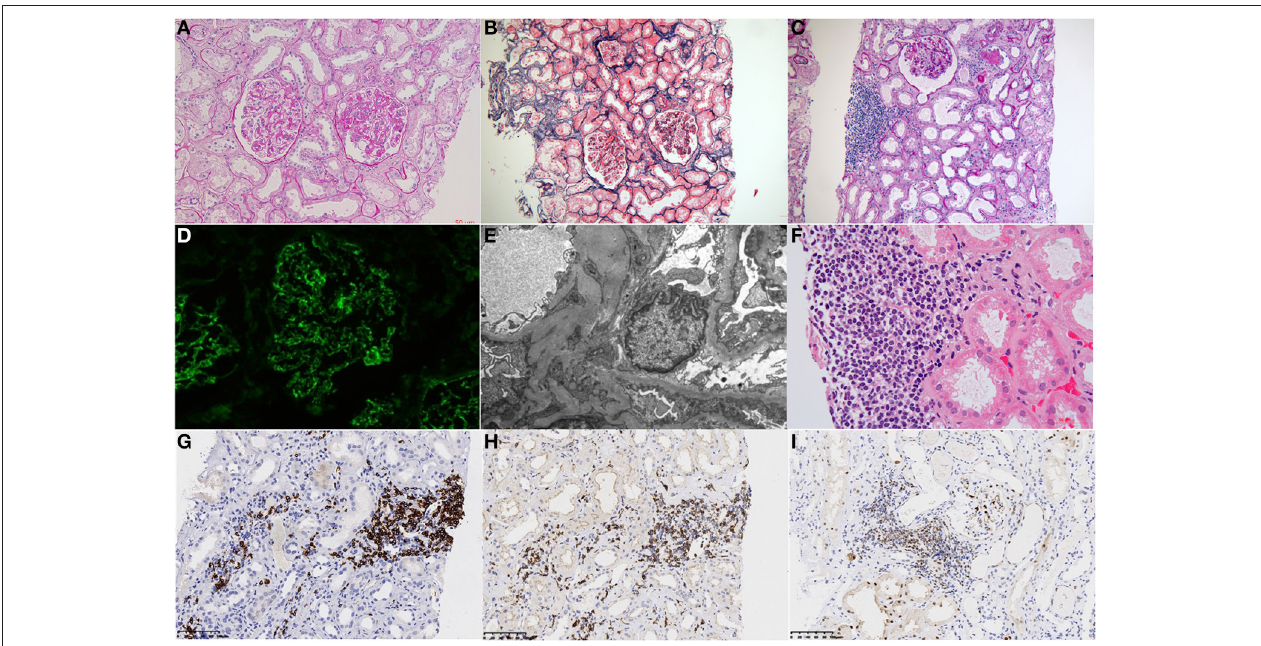
FIGURE 1 | Histological findings on renal biopsy. (A) Light microscopy study of the renal biopsy specimen revealed segmental endocapillary proliferation with neutrophil infiltration. (PAS, × 400). (B) The tubules displayed acute injury with epithelial simplification and small focal atrophy (Masson trichrome staining, × 200). (C) Renal interstitial was infiltrated by focal lymphocytes ( × 100). (D) Immunofluorescence analysis revealed positive granular staining of IgG in the mesangium and capillary wall. (E) Electron microscopy showing electron-dense deposits in the sub-epithelial and segmental mesangial. (F) Interstitial infiltration of a nodular mass of